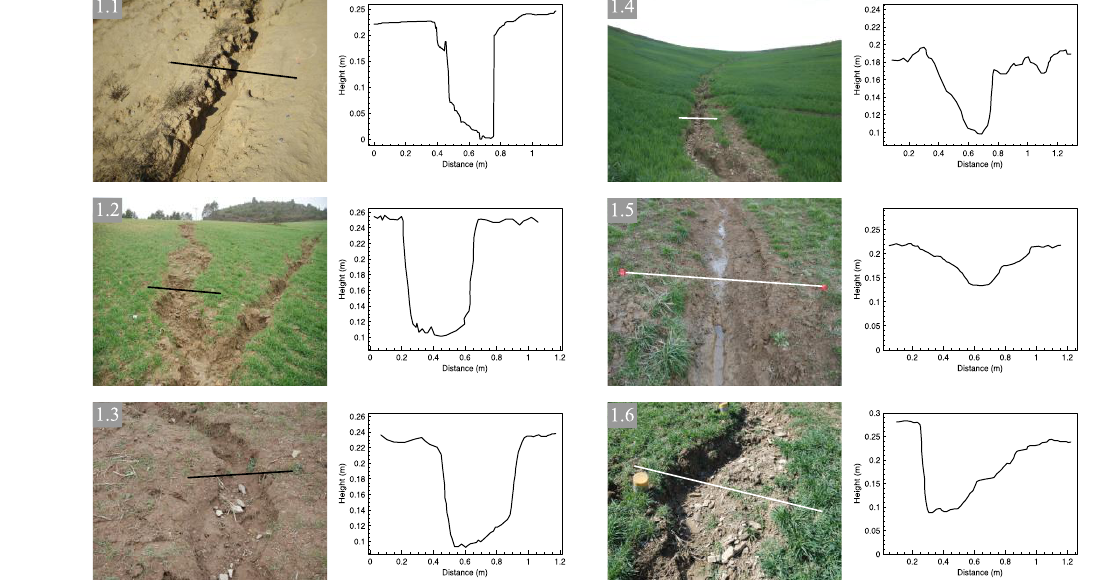
Figure 1. Examples of cross sections of typical ephemeral gullies (Navarre, Spain).